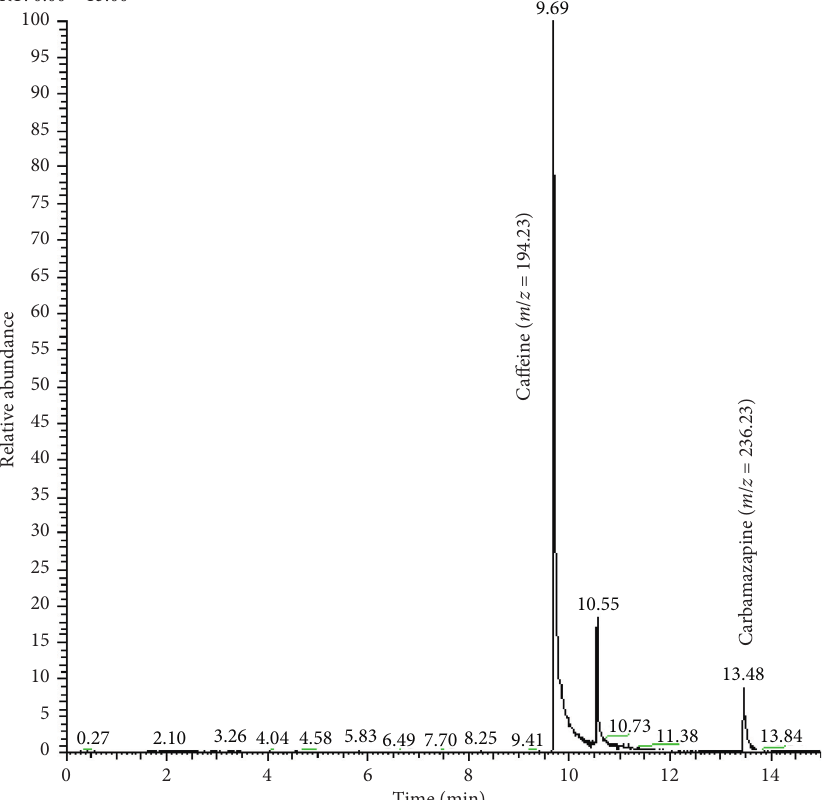
Figure 1: Representative selective ion chromatogram of standard solution (10 μ g/mL) showing caffeine and carbamazepine at m / z 194 and 236,